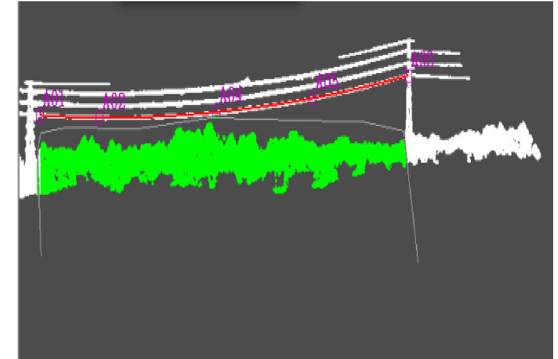
Fig. 7 Point cloud classification. The green part represents the vegetation on the surface and houses of the visible points, then the distances between trees and wires can be